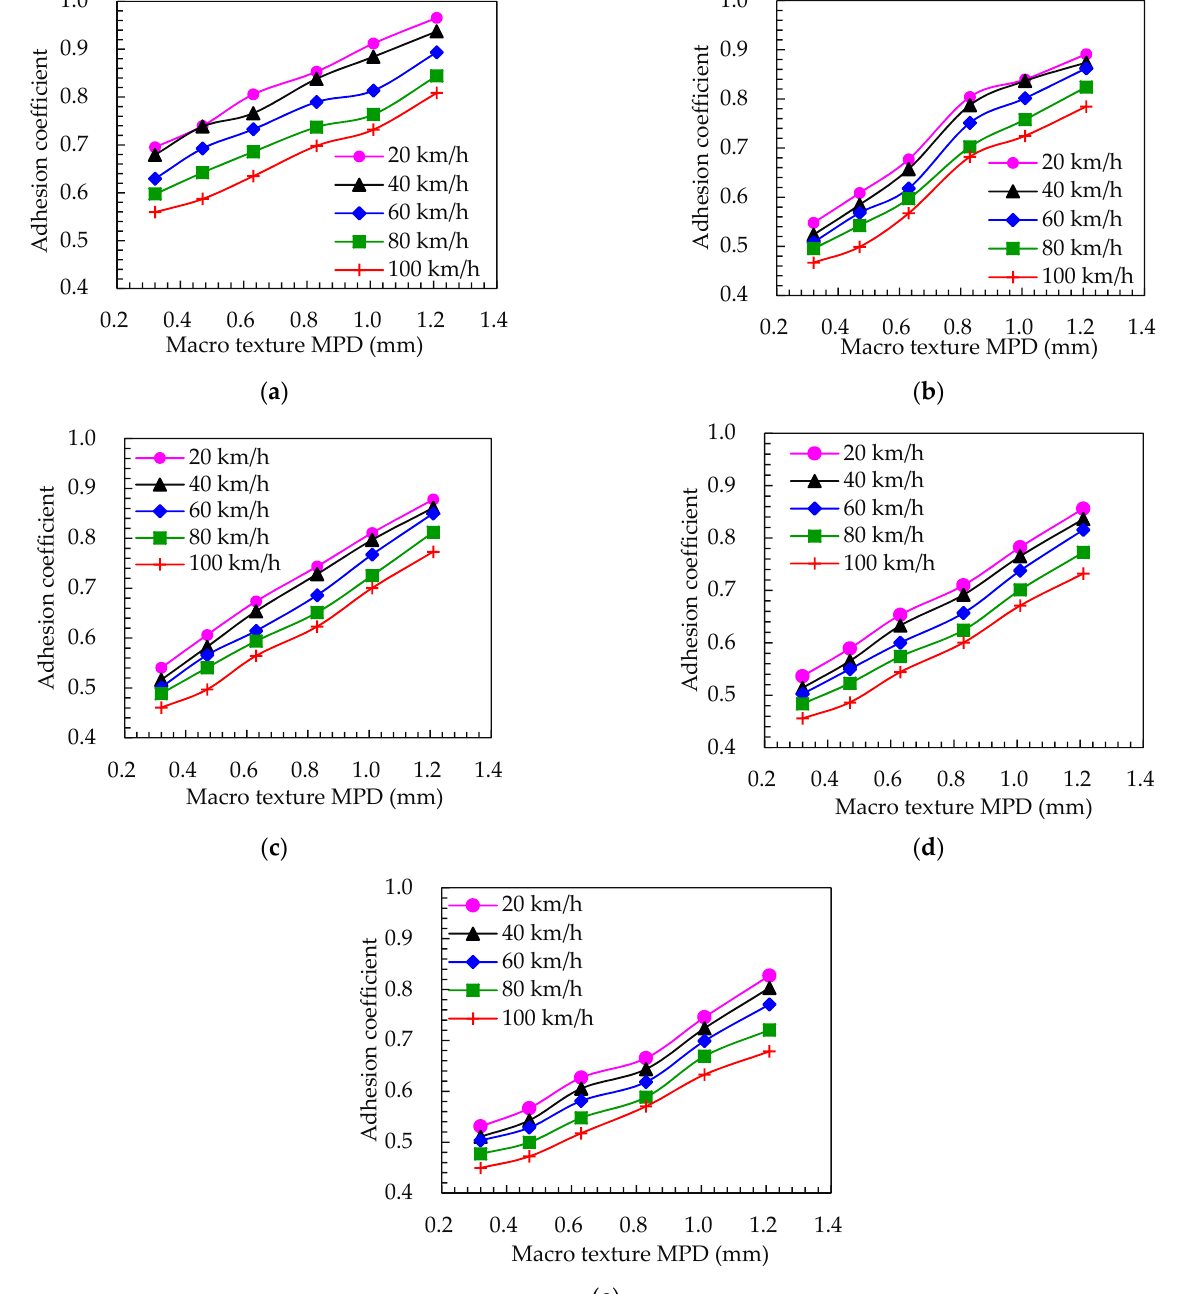
Figure 10. ( a ) h w = 0.2 mm; ( b ) h w = 1.0 mm; ( c ) h w = 2.0 mm; ( d ) h w = 3.5 mm; ( e ) h w = 5.0 mm. Influence of water film thickness on adhesion coefficient in a wet road state.